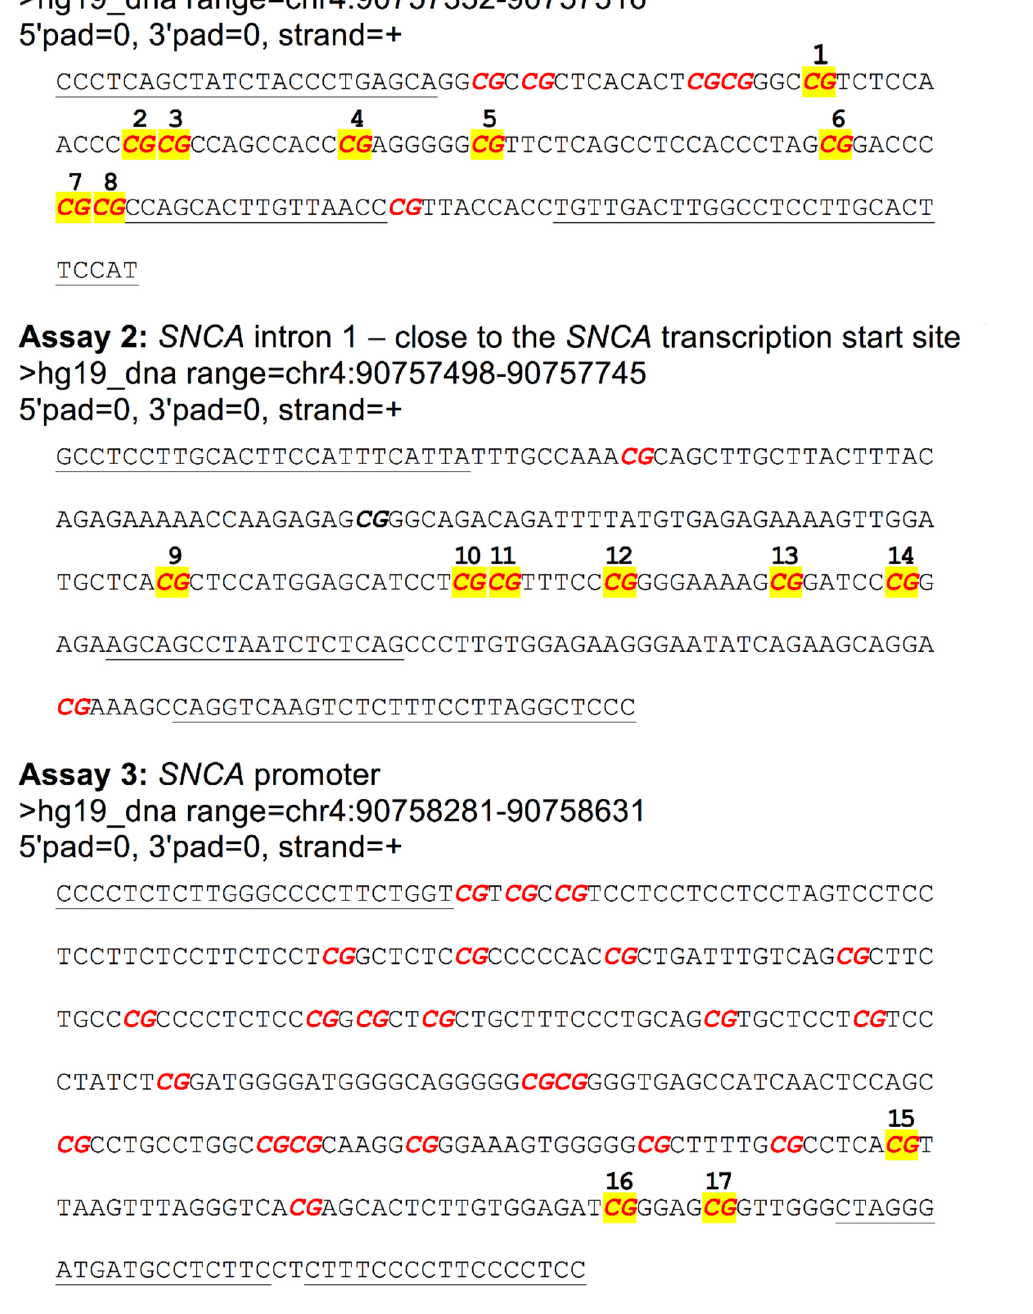
Figure 3. Location of the measured CpG sites within the promoter and intron 1 of the SNCA gene (which is encoded on the minus strand of chromosome 4). Legend: In bold red—CpG sites; yellow highlight—CpG sites used in this work; underline—annealing sequences of PCR primers and pyrosequencing